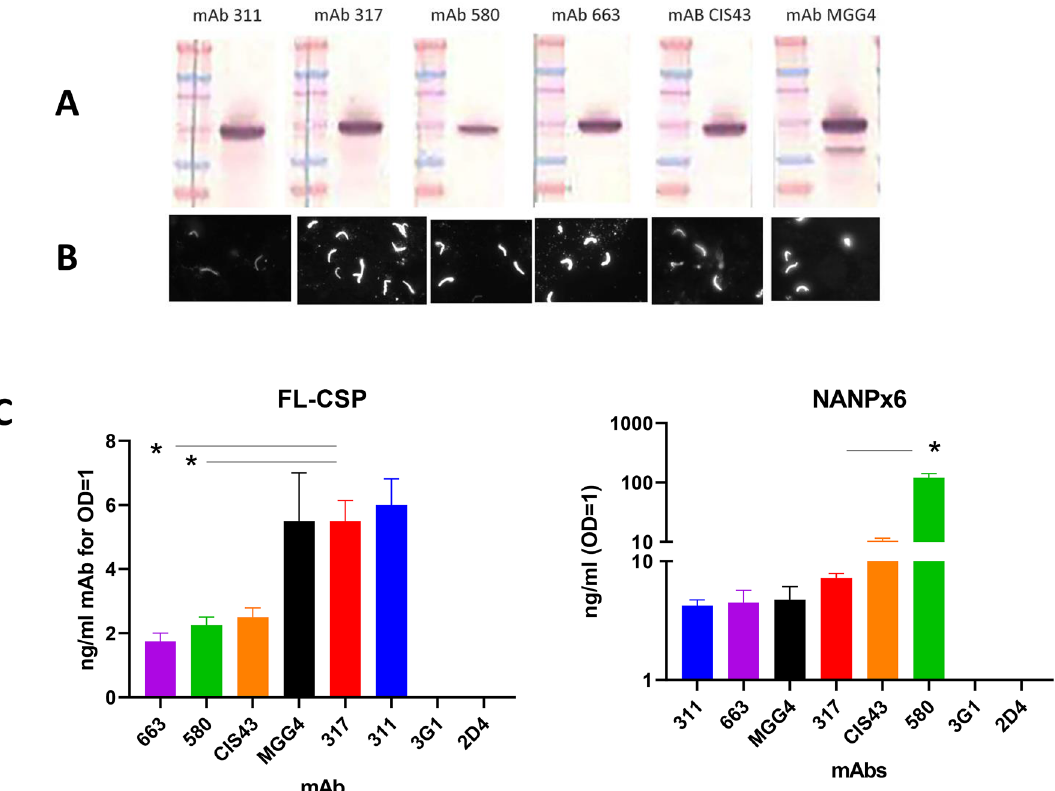
Figure 2. Immuno-reactivity of mAbs. ( A ) Western blot, ( B ) Immunofluorescence assay against Plasmodium falciparum NF54 strain sporozoites. ( C ) ELISA reactivity (ng/ml mAb needed for OD = 1) of mAbs against FL-CSP protein and NANPx6 peptide. Mean and standard error from four independent experiments; mAbs 2D4 and 3G1 were negative controls. Comparisons against mAb 317; (*) indicate level of significance for ng/ml mAb differences determined by ANOVA and p values corrected for multiple comparisons by Tukey’s method.